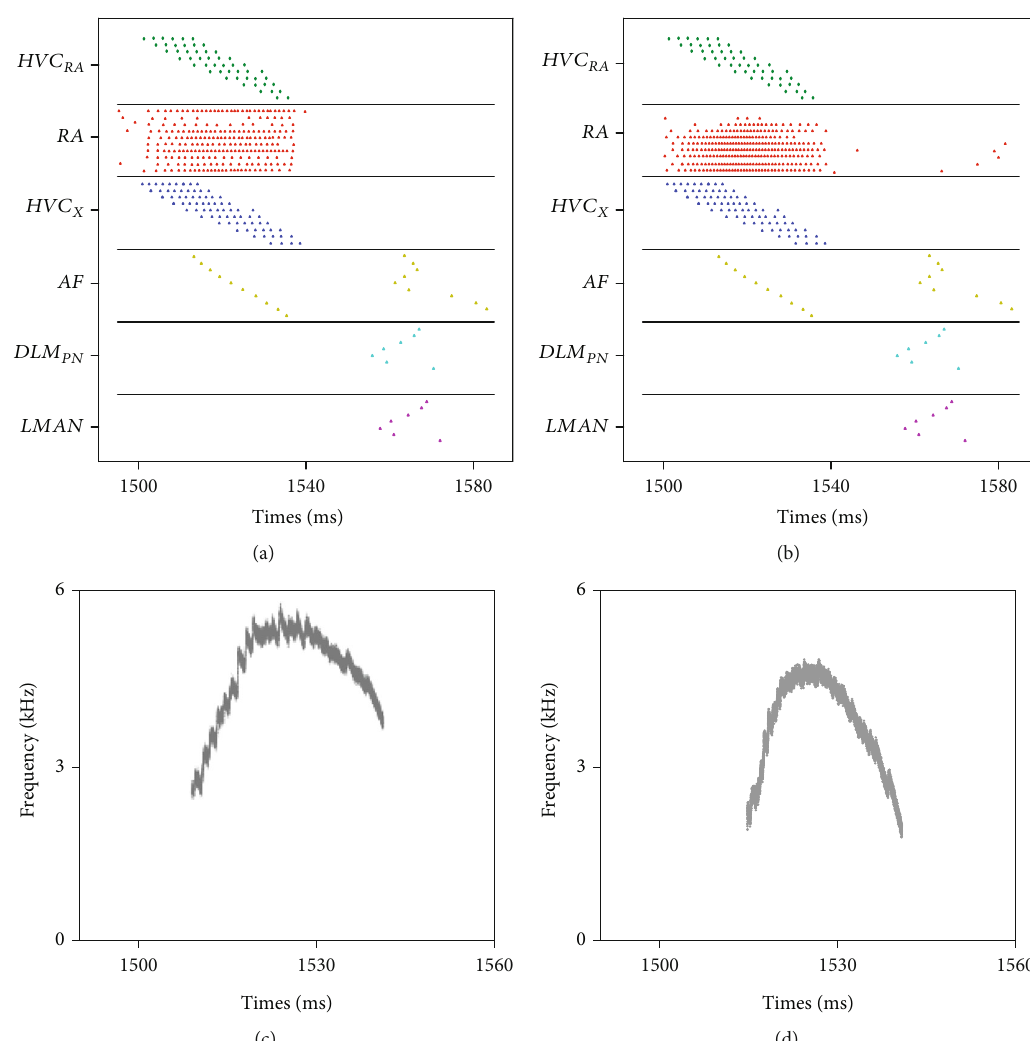
Figure 9: The raster plots and syllables at the fi rst trial and 1000th trial. (a) and (b) show birdsong neural circuit activities before and after training, respectively, where each point represents a spike. (c) and (d) are the corresponding syllables with a basic frequency between 2 and